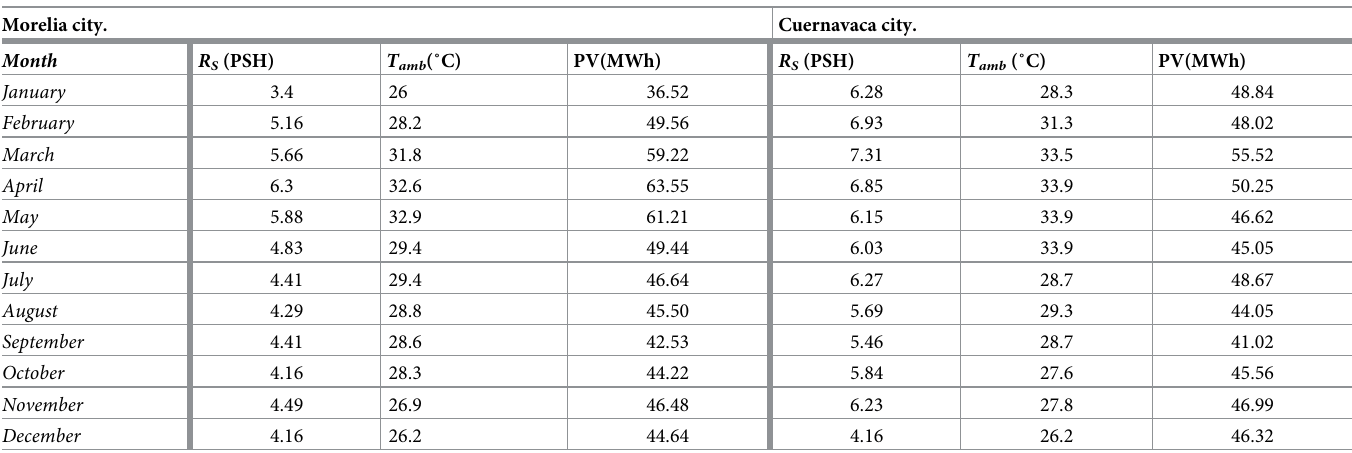
Table 8. PV System energy production. Morelia city. Cuernavaca city.